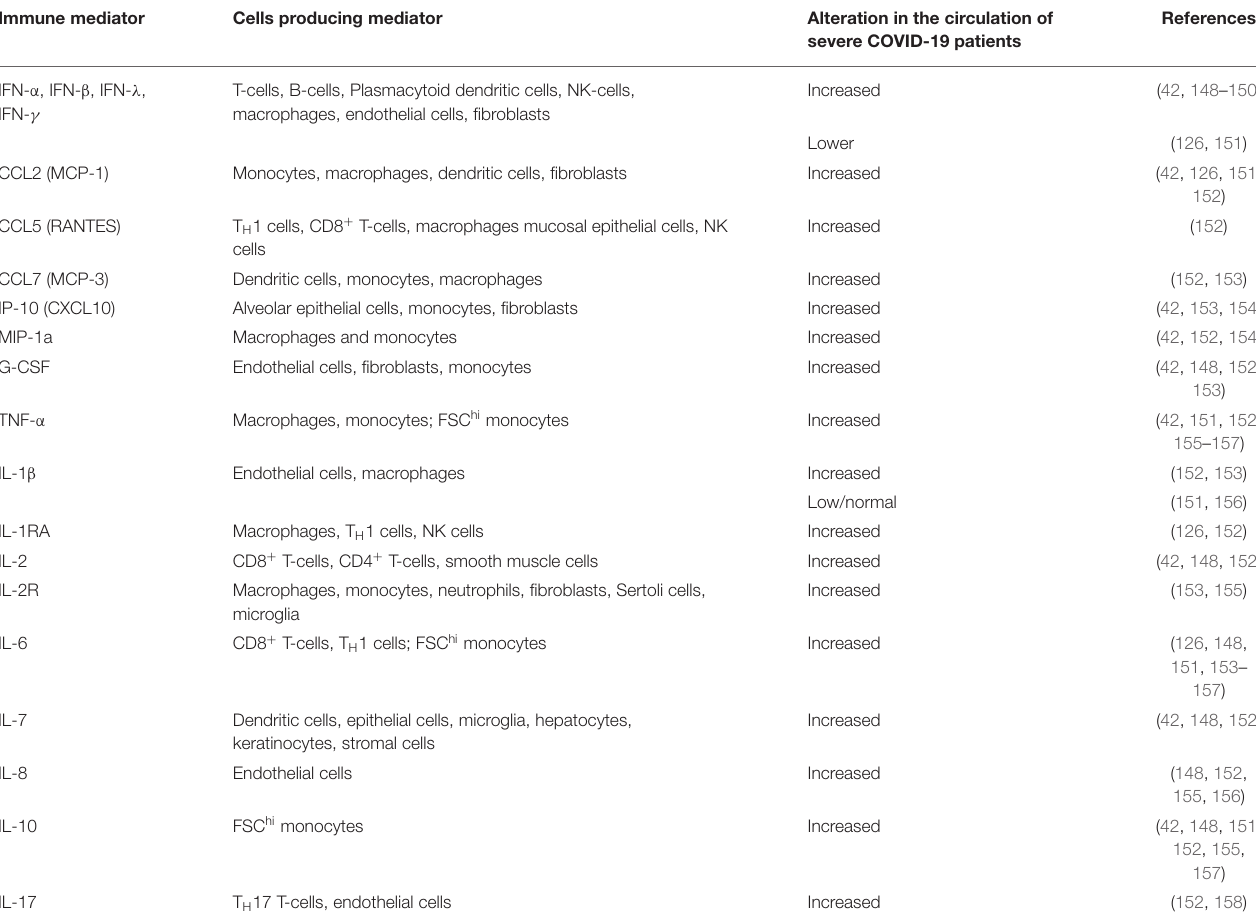
TABLE 2 | Immune mediators dysregulated in severe